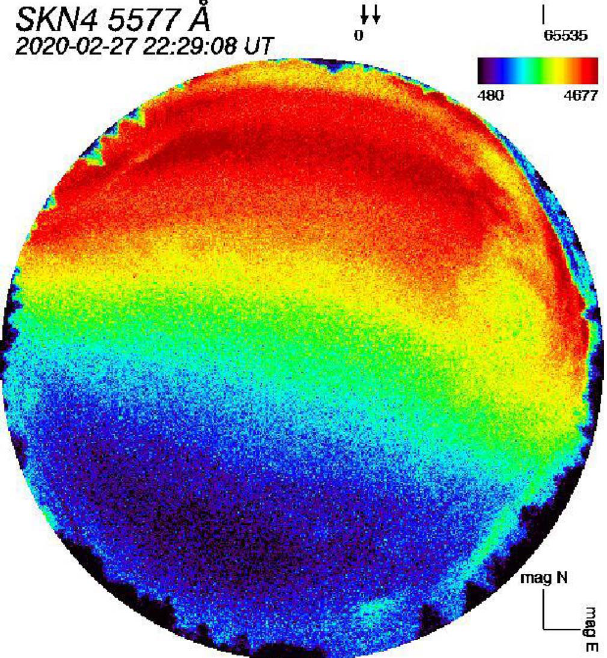
Fig. A.2. All-sky camera image of the auroral emissions in the 557.7 nm line used as input of the model for the observations on February 27th, 2020. The color scale gives the emission photon fl ux in Rayleigh unit (10 10 photons/m 2